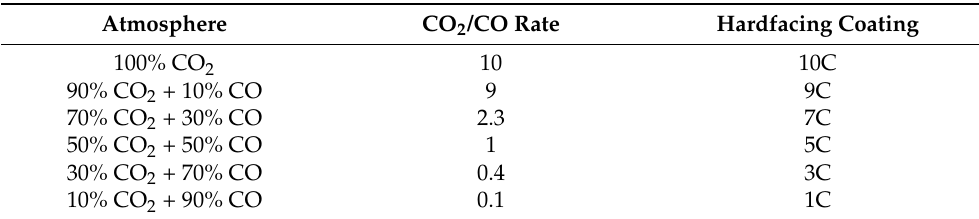
Table 4. Hardfacing coating name, sintering atmosphere and CO 2 /CO rate in the sintering atmosphere.